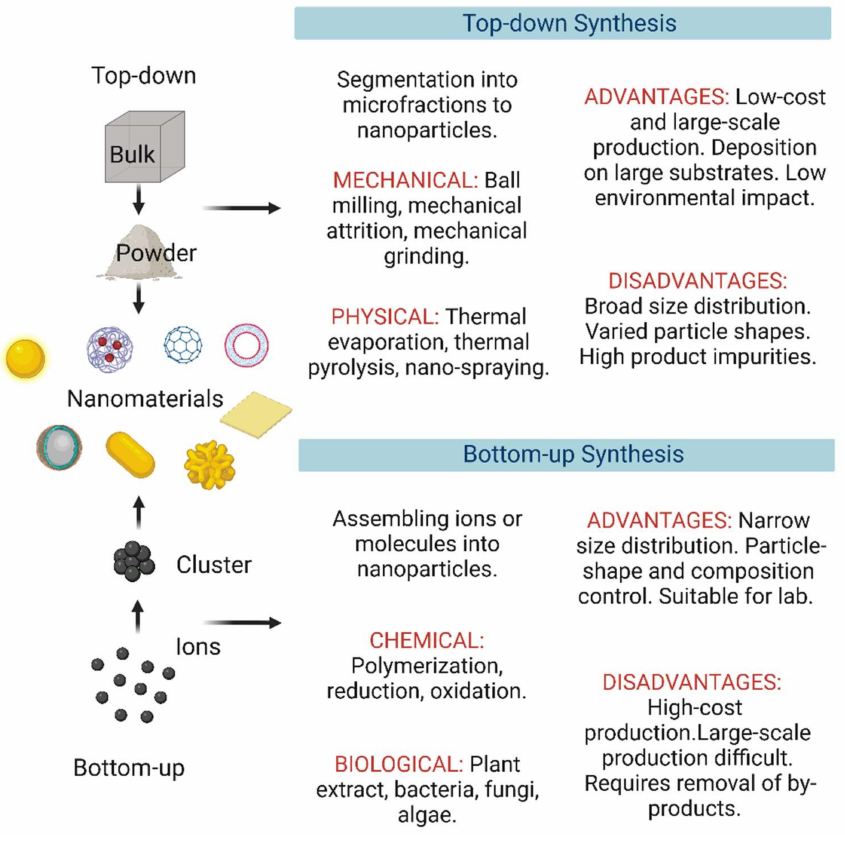
Figure 5. Schematic representation of top-down and bottom-up techniques for nanomaterial fabrica- tion. Figure created with